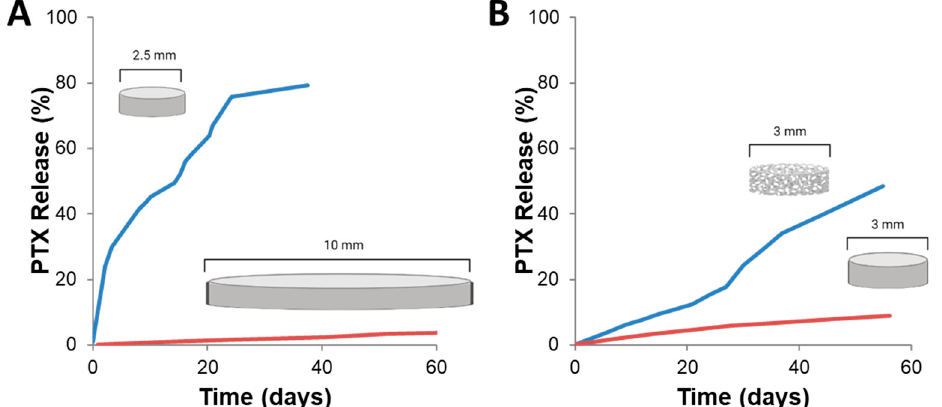
Figure 9. Effect of surface area to volume ratio on release of paclitaxel (PTX) from drug delivery devices. Images of published in vitro release curves were analyzed using Automeris WebPlot Digitizer. Data were exported to Excel and plotted together on the same x and y axis for ease of viewing. ( A ) PTX release from p(CPP:SA) (20:80) wafers. Blue lines from Walter et al. [31] is PTX release from 2.5 mm, 10 mg compressed wafers formulated for rats. Red line from Fung et al. [55] is PTX release from 10 mm, 200 mg compressed wafers formulated for primates. ( B ) PTX release PLGA wafers from Lee et al. [77] The blue line is ~3 mg porous foam wafer, 3 mm diameter × 1 mm tall. The red line is the same foam, compressed into a solid wafer ~8 mg with the same dimensions (3 mm diameter × 1 mm tall). ( A ) is slightly modified and reproduced with permission from